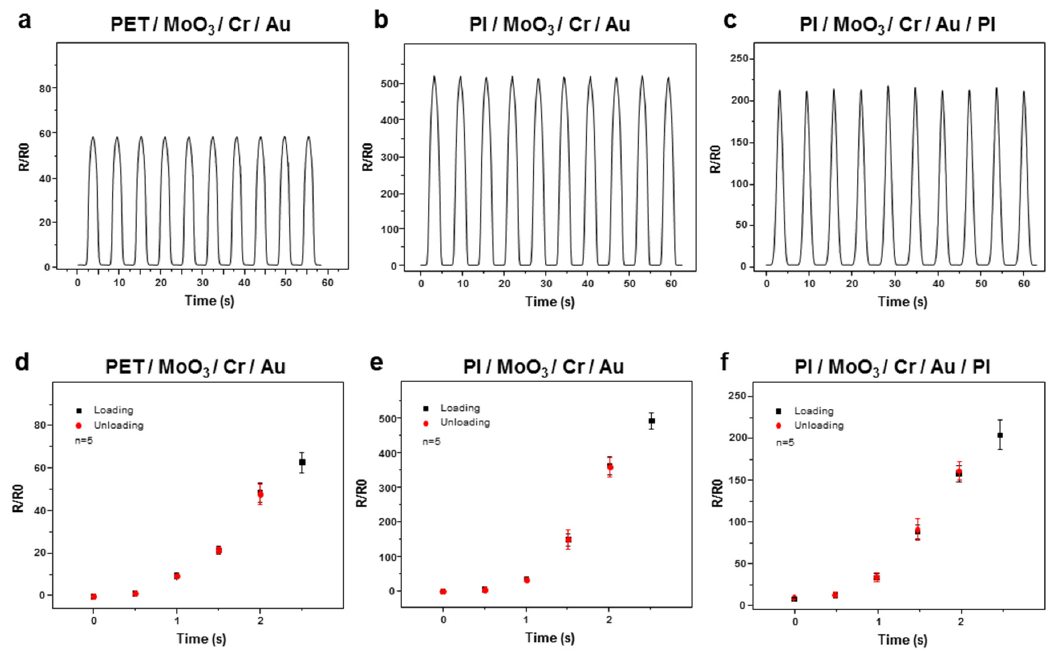
Figure 5. The normalized resistance variations of the crack sensors with strain. ( a ) The normalized resistance variance versus two-percent strain in 10 times cyclic test of the crack sensor on PET substrate. ( b ) The crack sensor on PI substrate without the encapsulating layer. ( c ) The crack sensor on PI substrate with the encapsulating layer. ( d ) Reproducible and hysteresis test obtained from crack sensors on PET substrate. ( e ) Crack sensors on PI substrate without the encapsulating layer. ( f ) The crack sensors on PI substrate with the encapsulating layer.